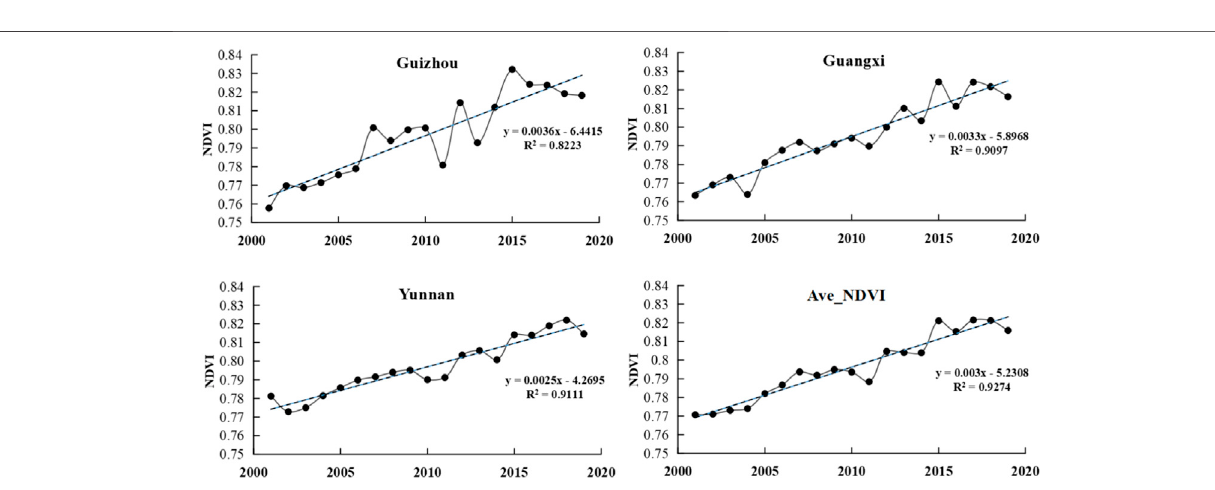
FIGURE 4 | Variation of annual NDVI in the three karst provinces of southwest China during 2001 – 2019.